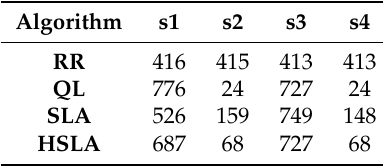
Table 7. Server (feeder link) selection count for Scenario-2 (POST).